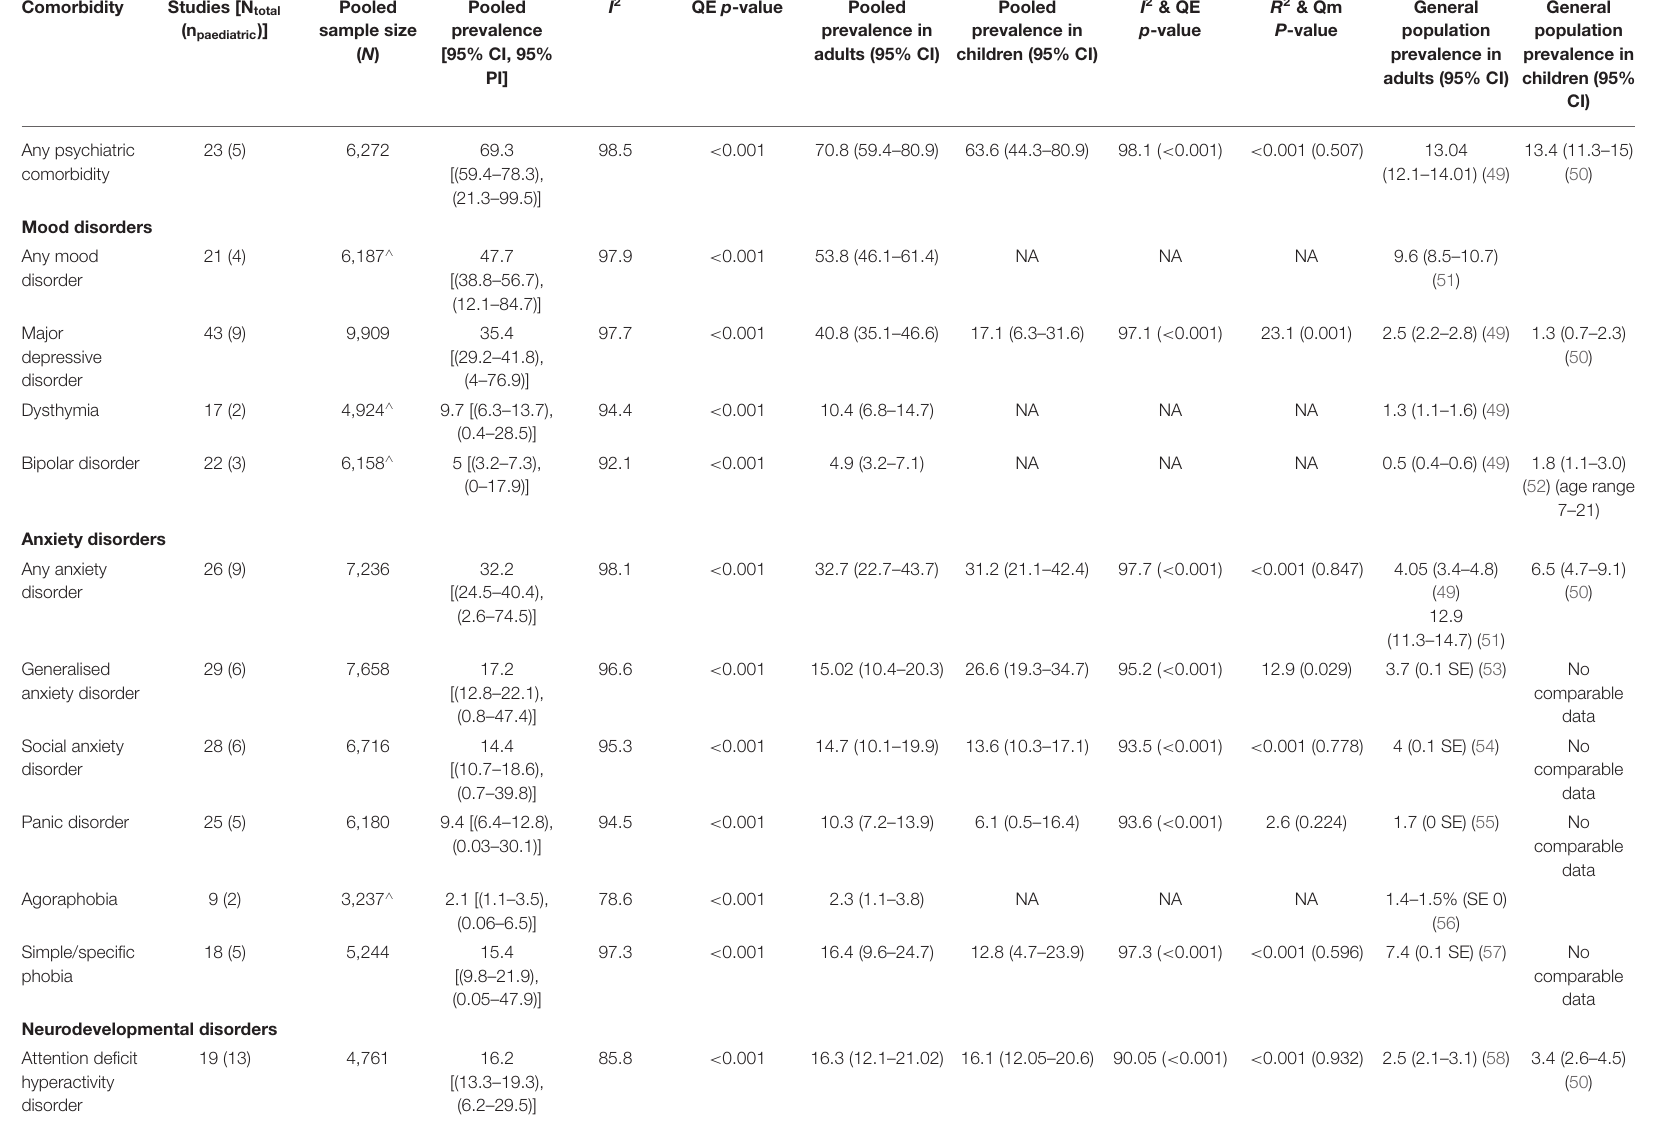
TABLE 1 | Pooled prevalence of psychiatric comorbidities in obsessive compulsive disorder. Comorbidity Studies [N total Pooled (n paediatric )] sample